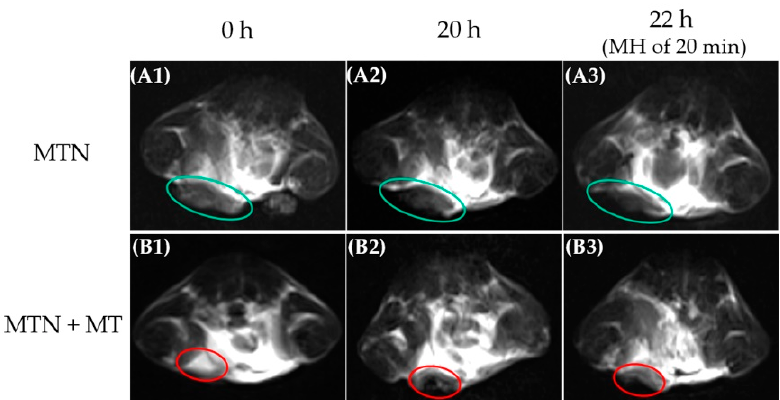
Figure 8. T2-weighted MRI results of orthotopic breast tumor before and after i.v. administration of MTN with corresponding treatments: MTN ( A1 – A3 ) and MTN + MT ( B1 – B3 ). Before intravenous injection of MTN, orthotopic breast tumors were scanned by MRI as control ( A1 , B1 ). After injection, the duration time of MT was 4 h, and the tumors were scanned again at 20 h ( A2 , B2 ). After MH of 20 min, the third MRI results ( A3 , B3 ) were obtained at 22 h after intravenous injection of MTN. Because MTN has a suitable diameter of around 151 nm, MTN could distribute in solid tumors by EPR effect and induce slight darkening in a partial area of the tumor (Figure 8(A2)) compared to the counterpart without MTN injection (Figure 8(A1)). Unfortu-